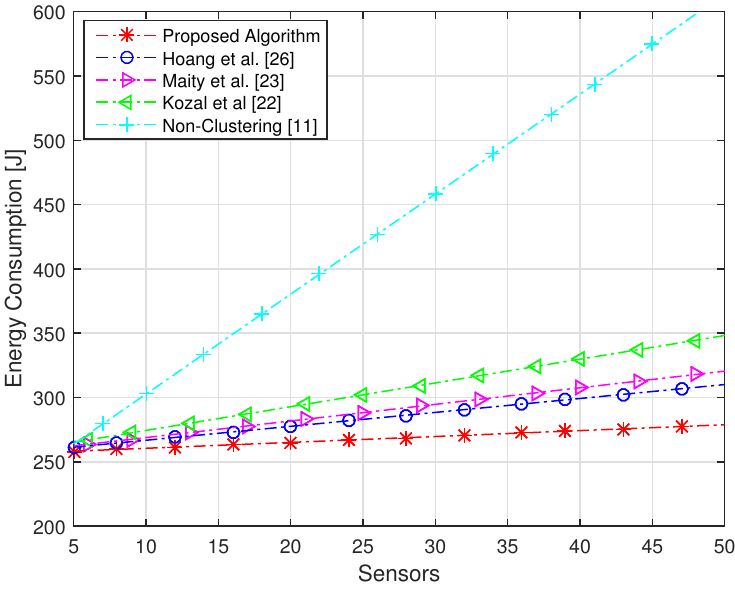
Figure 4. Energy consumption with an increasing number of